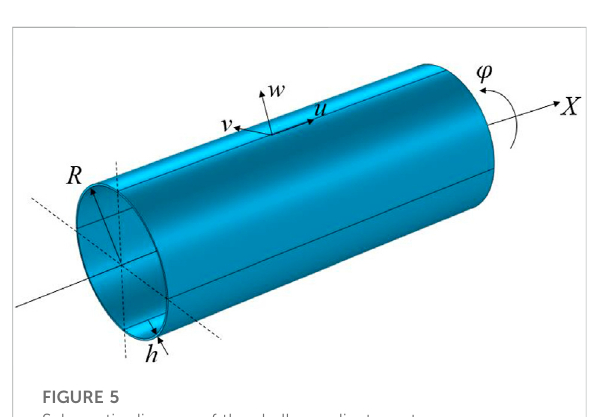
FIGURE 5 Schematic diagram of the shell coordinate